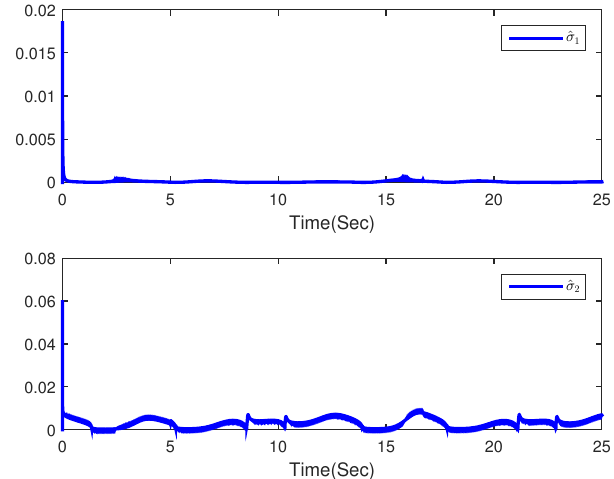
Figure 2. The curves of ˆ σ 1 and ˆ σ 2 (Case 1).